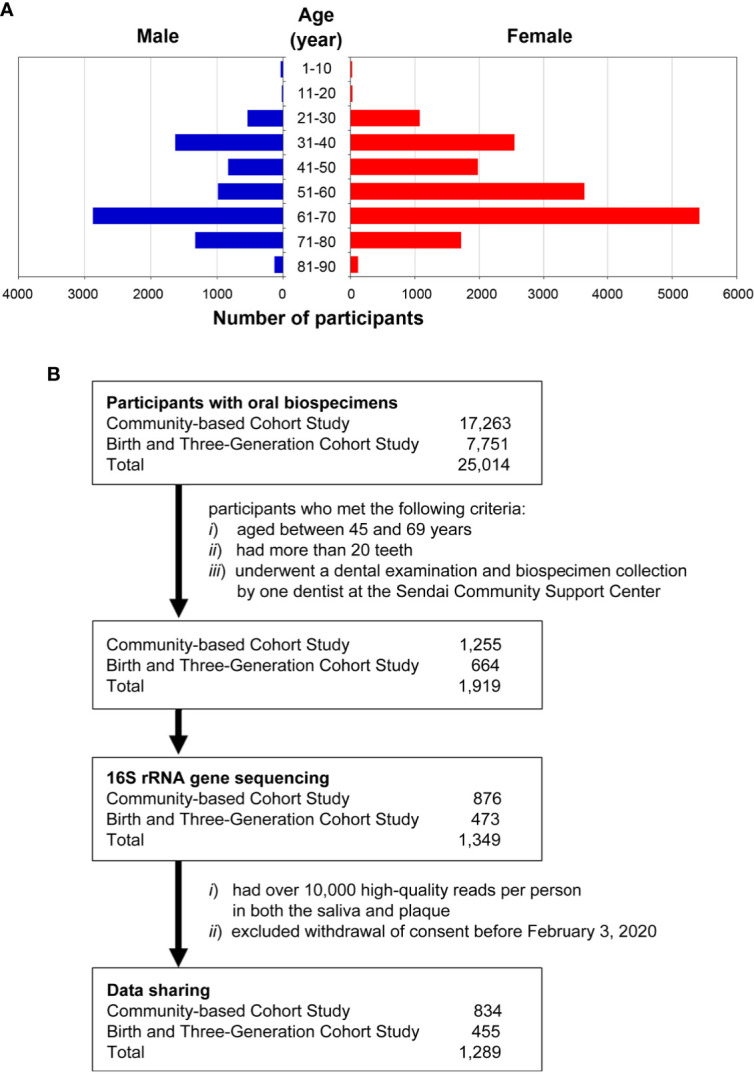
Overview of the participants in the ToMMo baseline oral microbiome study. (A) Sex and age distribution of the participants (n = 24,913) in the ToMMo baseline oral microbiome study. Of the 25,014 individuals from which oral biospecimens were collected, 101 were excluded due to missing information regarding gender, date of birth, or dental examination. (B) Number of participants registered in the TMM CommCohort Study and in the TMM BirThree Cohort Study. The flow chart shows the criteria for selecting the participants whose data were analyzed by 16S rRNA gene sequencing.